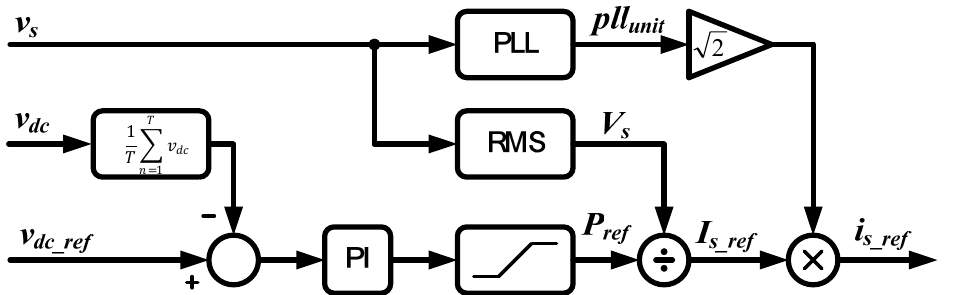
Figure 11. Block diagram of the reference current calculation in G2V slow battery-charging mode (based on [47]).